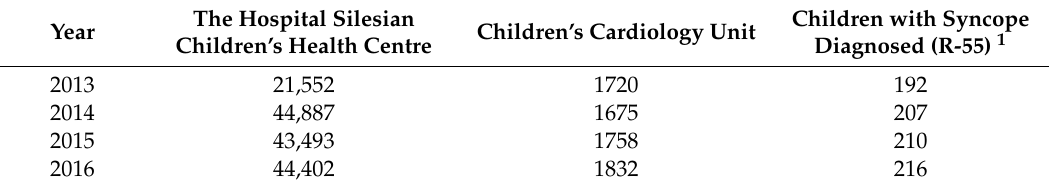
Table 1. Cases of syncope in children in the schedule of four years of hospital